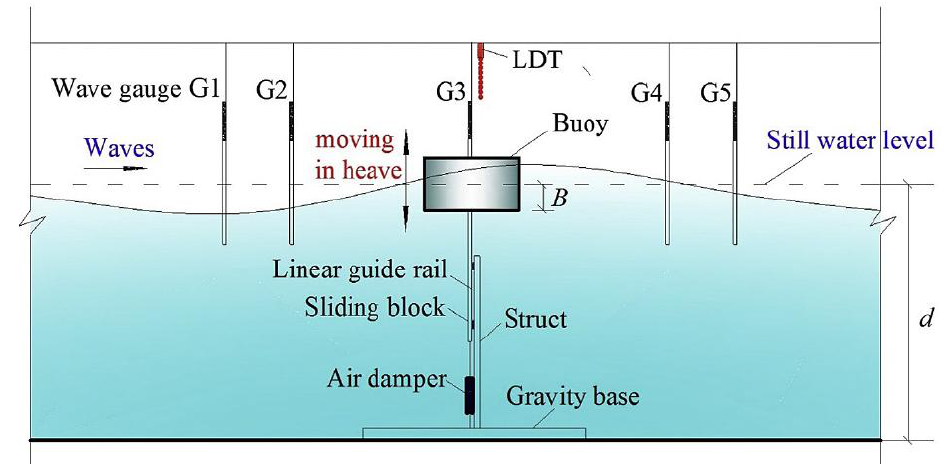
Figure 9. Experimental schematic of a heaving buoy connected to an air damper which simulates a permanent magnet linear generator [83] .